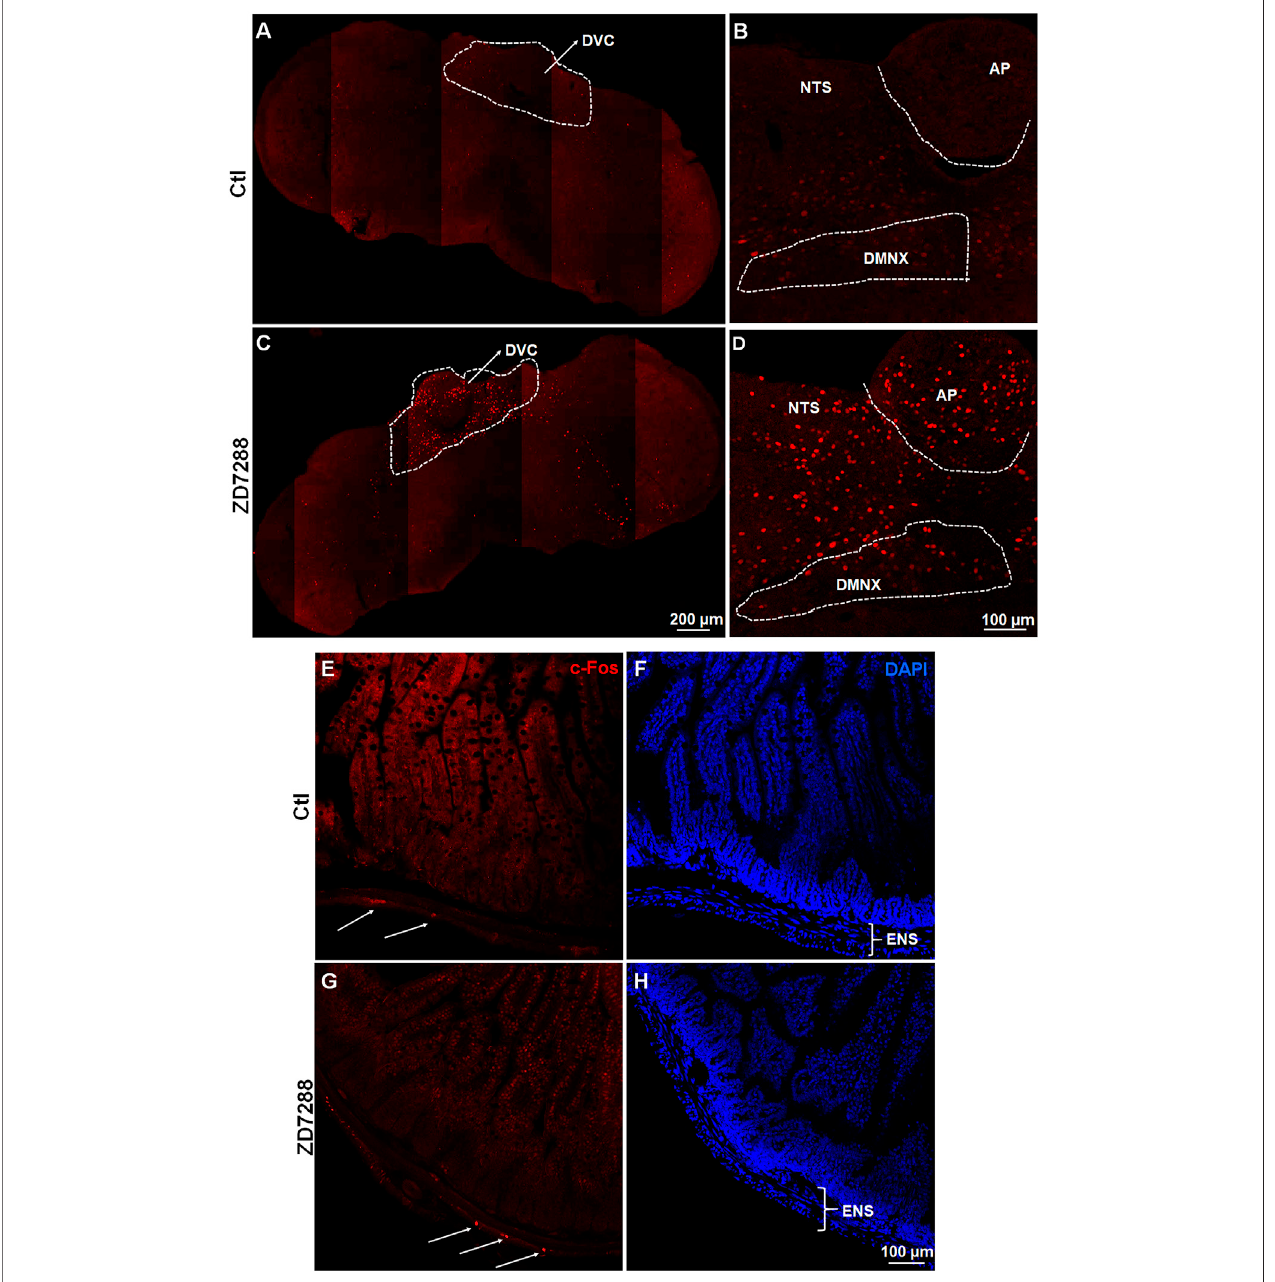
FIGURE4| Immunohistochemical analysisofc-Fosfollowingemesis induced bysystemic administration oftheHCN channel blocker ZD7288. Leastshrews were sacri fi ced 90 min post vehicle treatment, or after the fi rst vomiting occurred post systemic administration (1 mg/kg, i. p.) of ZD7288 ( n (cid:2) 4 shrews per group). Shrew brainstem section (20 μ m) and intestinal jejunum sections (25 μ m) were stained with rabbit c-Fos antibody and Alexa Fluor 594 donkey anti-rabbit secondary antibody. Nuclei were stained with DAPI in blue. (A, C) Representative tile-scanned images show a robust c-Fos induction in the brainstem dorsal vagal complex (DVC) in responsetoZD7288 (1 mg/kg,i.p.). Scalebar,100 μ m. (B,D) Representativesingle fi ledimages (20x) showc-Fosexpression evokedbyZD7288observedintheDVC emetic nuclei, the area postrema (AP), the nucleus tractus solitarius (NTS) and the dorsal motor nucleus of the vagus (DMNX), within the brainstem. Scale bar, 200 μ m. ( E – H ) Representative images (20x) show low c-Fos expression induced by ZD7288 in the enteric nervous system (ENS) of the intestinal jejunum. Scale bar, 100 μ m.